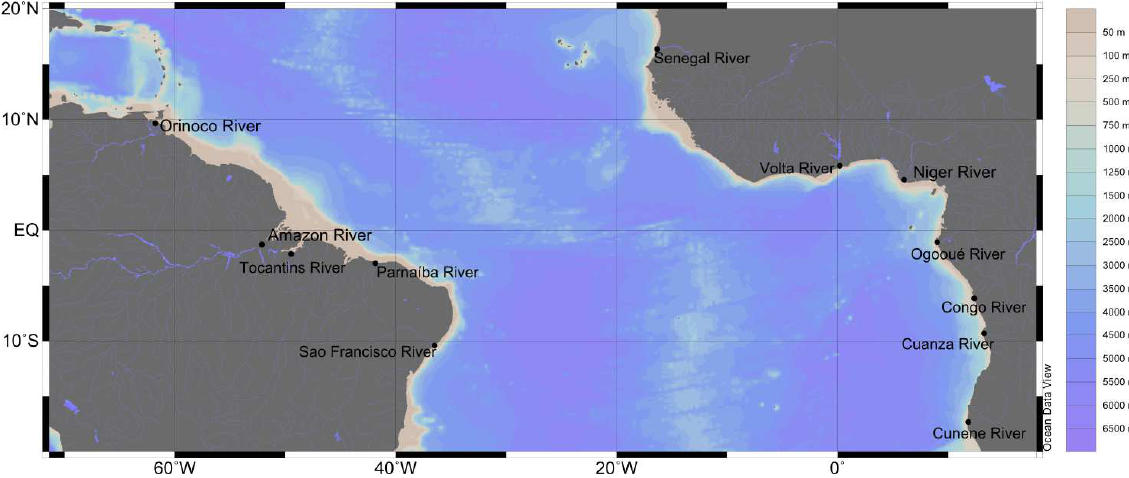
Fig. 1. Map of the tropical Atlantic Ocean showing the location of the main rivers outflow ( • ). The colored side bar represents the bottom topography (Schlitzer, R.,